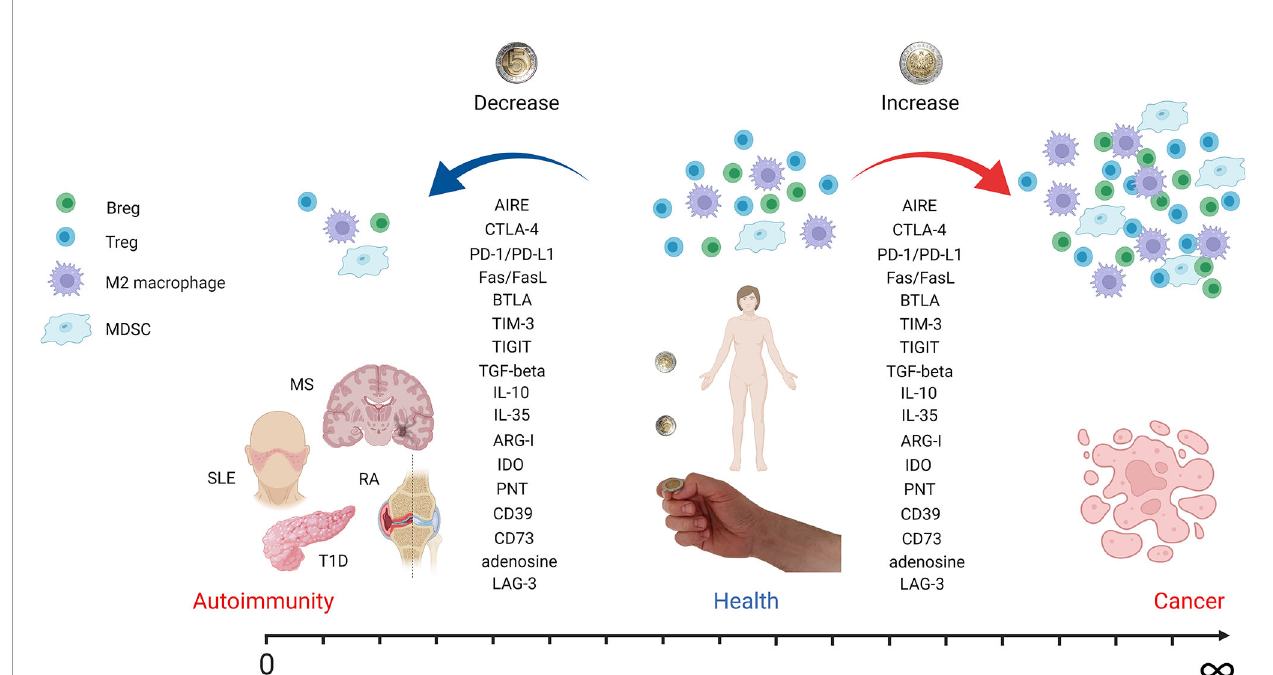
FIGURE 1 | Autoimmunity and cancer as two sides of the same coin. The fi gure depicts how tuning of immune system regulatory mechanisms can contribute to autoimmunity, health, or cancer development. A decrease in regulatory cell populations like Tregs, Bregs, M2 macrophages, and MDSCs leads to autoimmune disease onset. However, an increase in the same cell subsets is associated with cancer development and progression. Effector molecules involved in immune tolerance induction are downregulated in autoimmunity but overexpressed in cancer. The most important molecules mentioned in the text are listed. AIRE, autoimmune regulator; CTLA-4, cytotoxic T-lymphocyte antigen 4; PD-1, programmed cell death receptor 1; PD-L1, programmed cell death ligand 1; BTLA, B- and T-lymphocyte attenuator; TIM-3, T-cell immunoreceptor with immunoglobulin and ITIM domain; TIGIT, T-cell immunoglobulin and ITIM domain; TGF-beta, transforming growth factor beta; IL, interleukin; ARG-I, arginase I; IDO, indoleamine-pyrrole 2,3-dioxygenase; PNT, peroxynitrite; LAG-3, lymphocyte-activation gene 3 ( fi gure created with